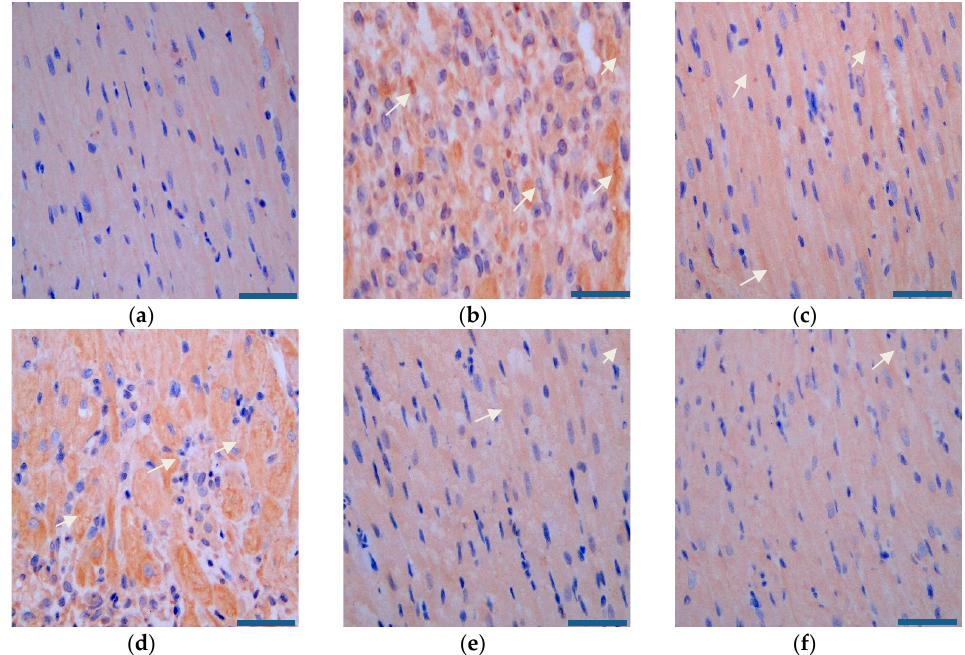
Figure 16. AMPK expression in the rat heart tissues (×400, scale bar = 200 μ m) of ( a ) the sham group, ( b ) the model group, ( c ) the positive drug group, ( d ) the miR-133 group, ( e ) the PEG-PLA/miR-133 group, and ( f ) the RGD-PEG-PLA/miR-133 group. Blue: nucleus, brown: AMPK-positive stain. White arrows indicate the regions of strongly positive AMPK expression.